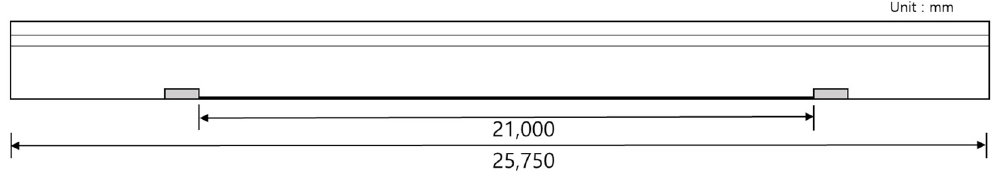
Figure 3. Geometry of specimen reinforced with the near-surface mounted (NSM) method.